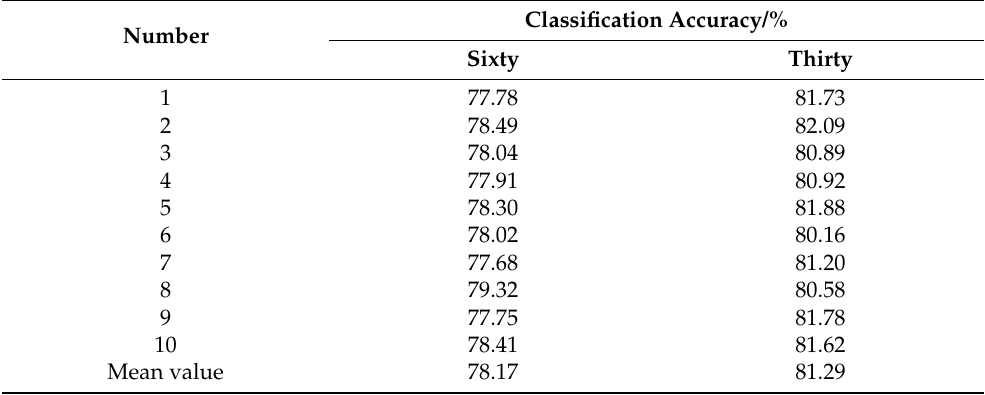
Table 5. Classification accuracies achieved by DT classifier on data sets composed of different number of sound